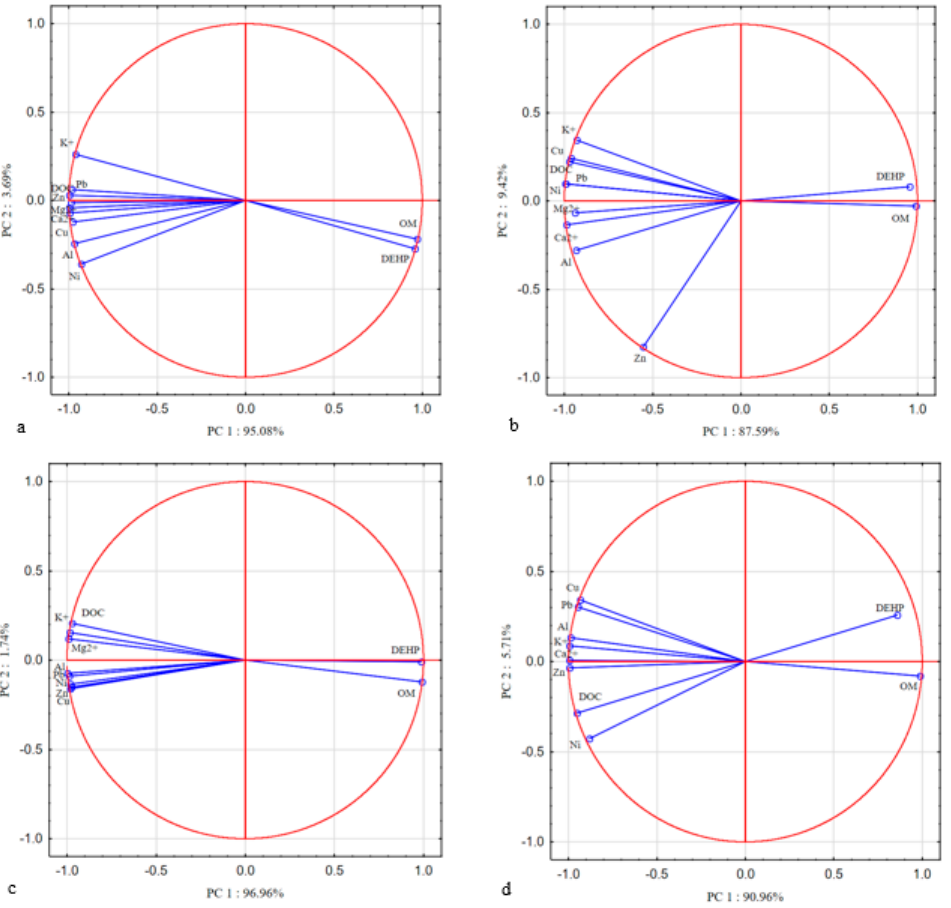
Figure 12. Principal Component Analysis – plot of variables. Location of load vectors towards two principal components for ( a ) UD; ( b ) H 2 O 2 /UD ( c ) H 2 O 2 /Fe 2+ /UD ( d ) H 2 O 2 /Fe 3+ /UD.